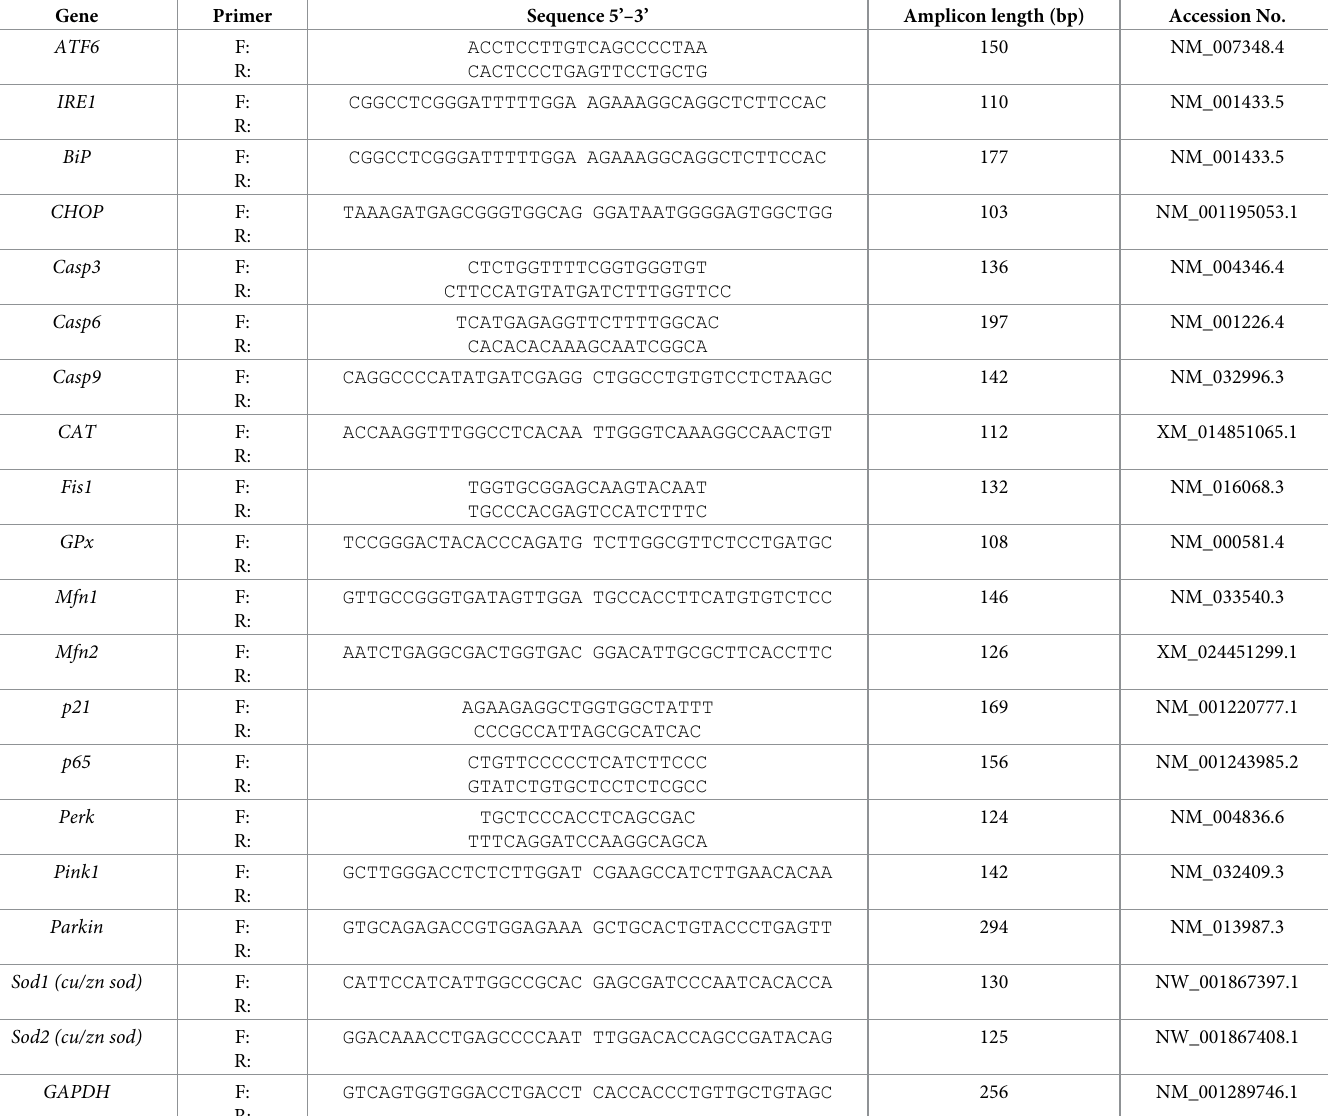
Table 1. Sequences of primers (Sigma Aldrich, Pozna ń , Poland) used in qPCR. Gene Primer Sequence 5’–3’ Amplicon length (bp) Accession